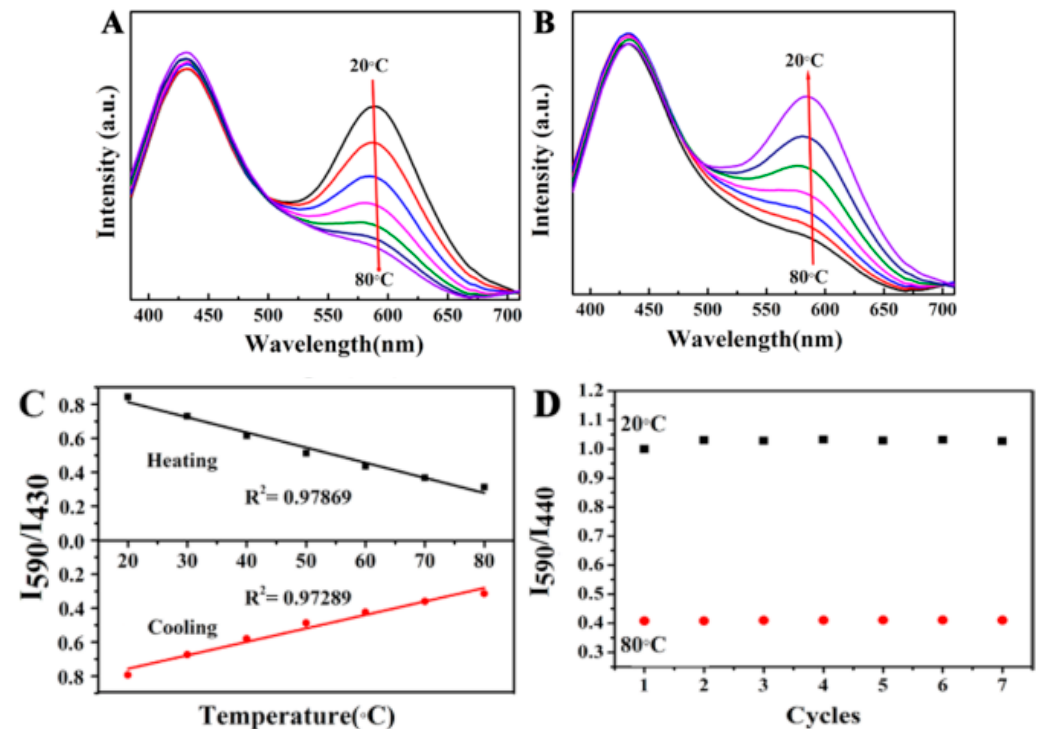
Figure 14. Temperature dependence of WCDs@PS’ FL intensity in the solid-state. ( A ) FL emission spectra excited at 380 nm as temperature increased from 20 to 80 °C. ( B ) FL emission spectra excited at 380 nm as temperature decreased from 80 to 20 °C. ( C ) Plots of the intensity ratio of 590/430 nm vs. temperature. ( D ) Eight cycles of intensities were recorded at the temperatures of 20–80 °C. Reprinted with permission from [73]. Copyright (2019) American Chemical Society.